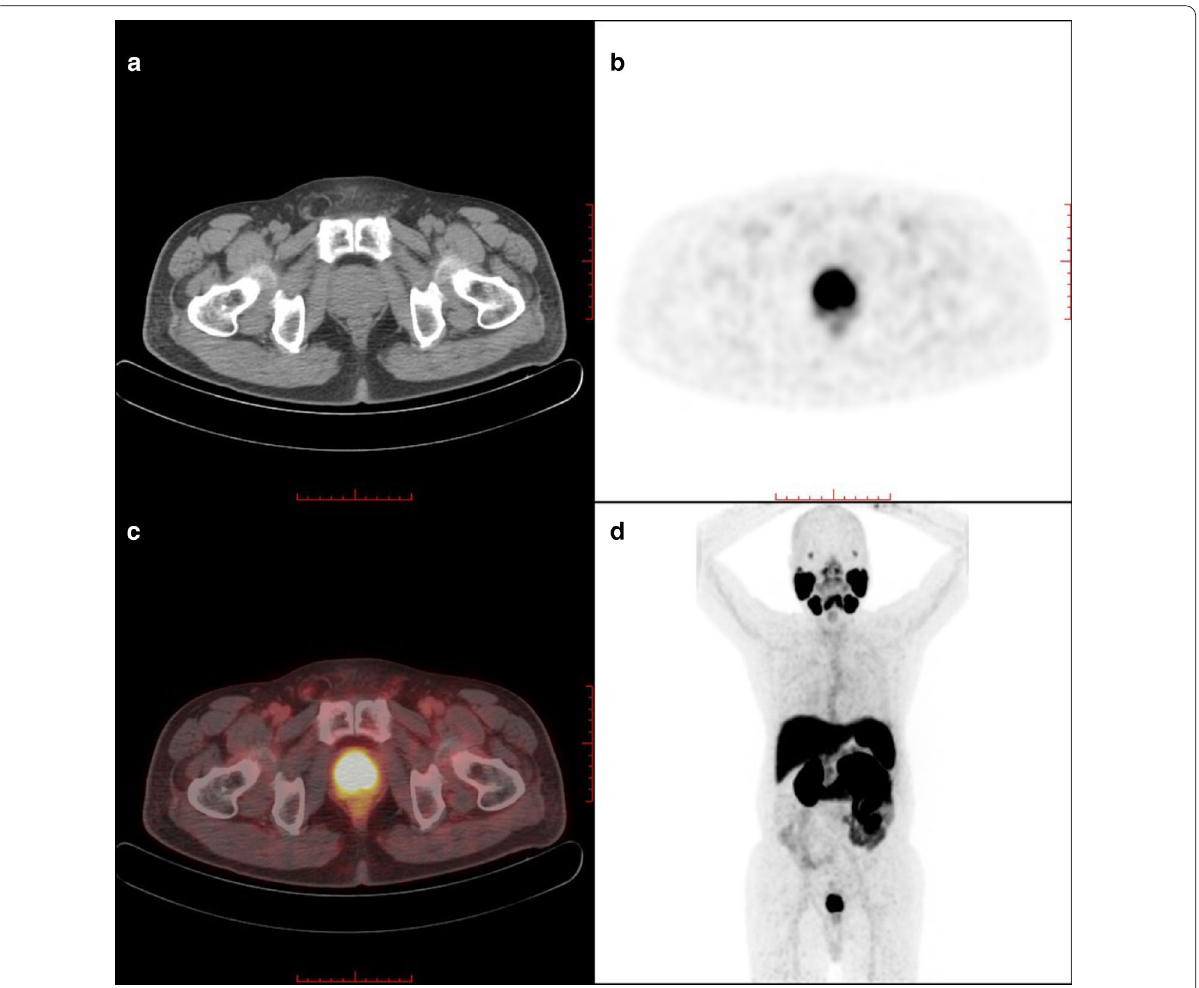
Fig. 3 18 F‑PSMA‑1007 PET/CT with CT ( a ), axial PET ( b ), fused PET/CT ( c ) and maximum‑intensity projection ( d ) images of a 70‑year‑old patient (GS, 9; PSA, 37.910 ng/ml). This patient was classified into HR group. Axial PET ( b ) and fused PET/CT ( c ) images showed diffuse hypermetabolism in the prostate gland (SUVmax: